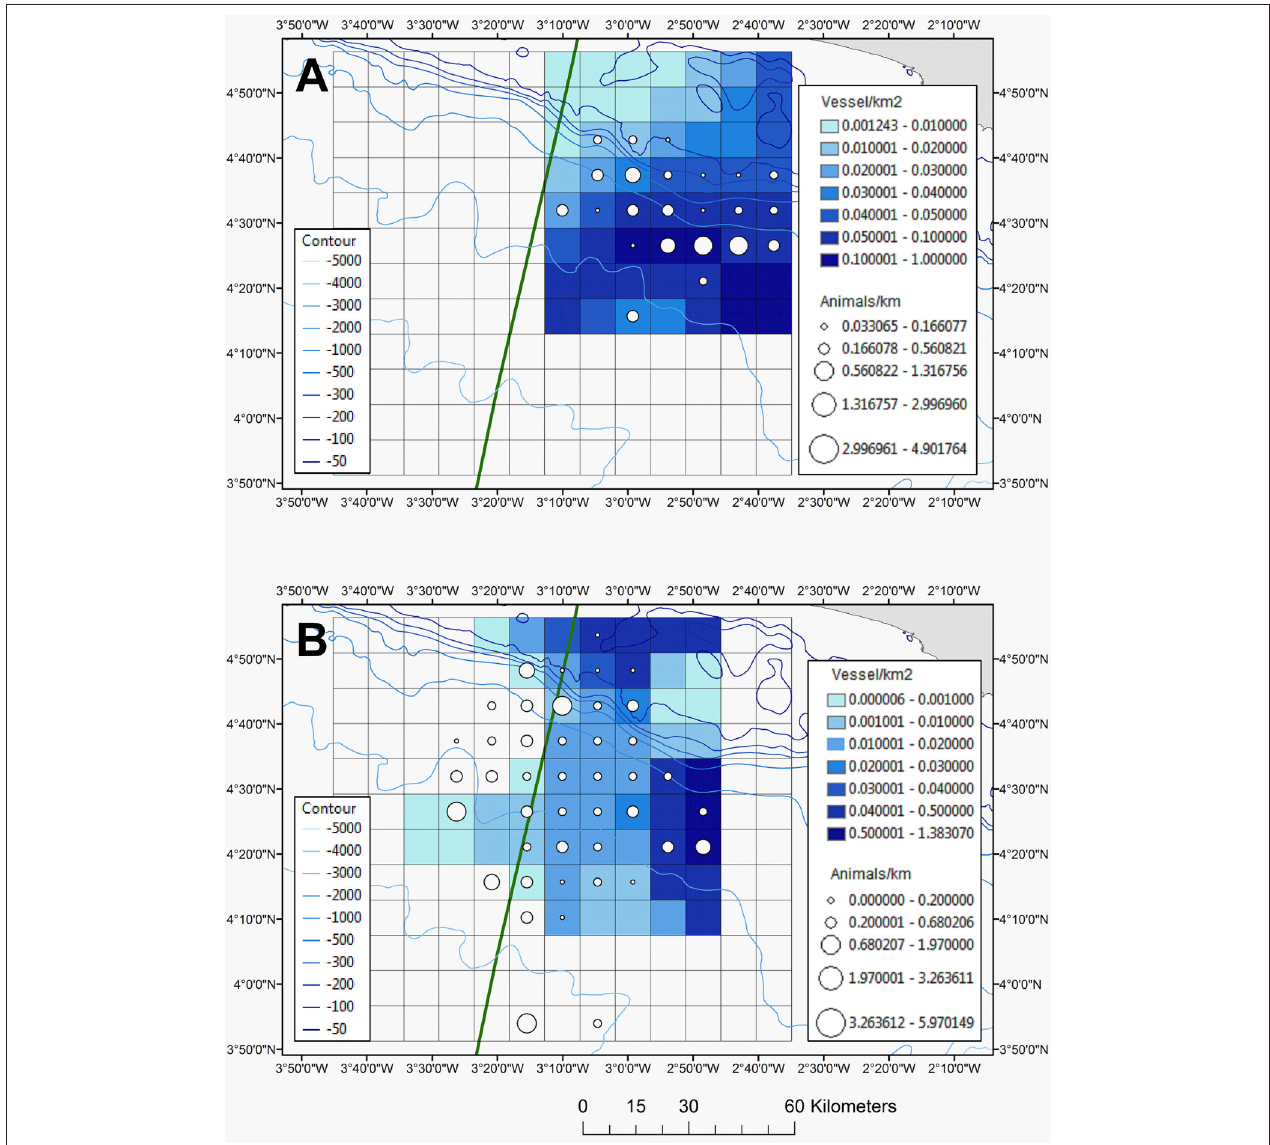
FIGURE 7 | The relative abundance of all cetaceans (animals km − 1 ) together with the density of all fishing vessels (boats km − 2 ) for 2013 (A) and 2014 (B). The EEZ border between Côte d’Ivoire and Ghana is also shown (green thick line).